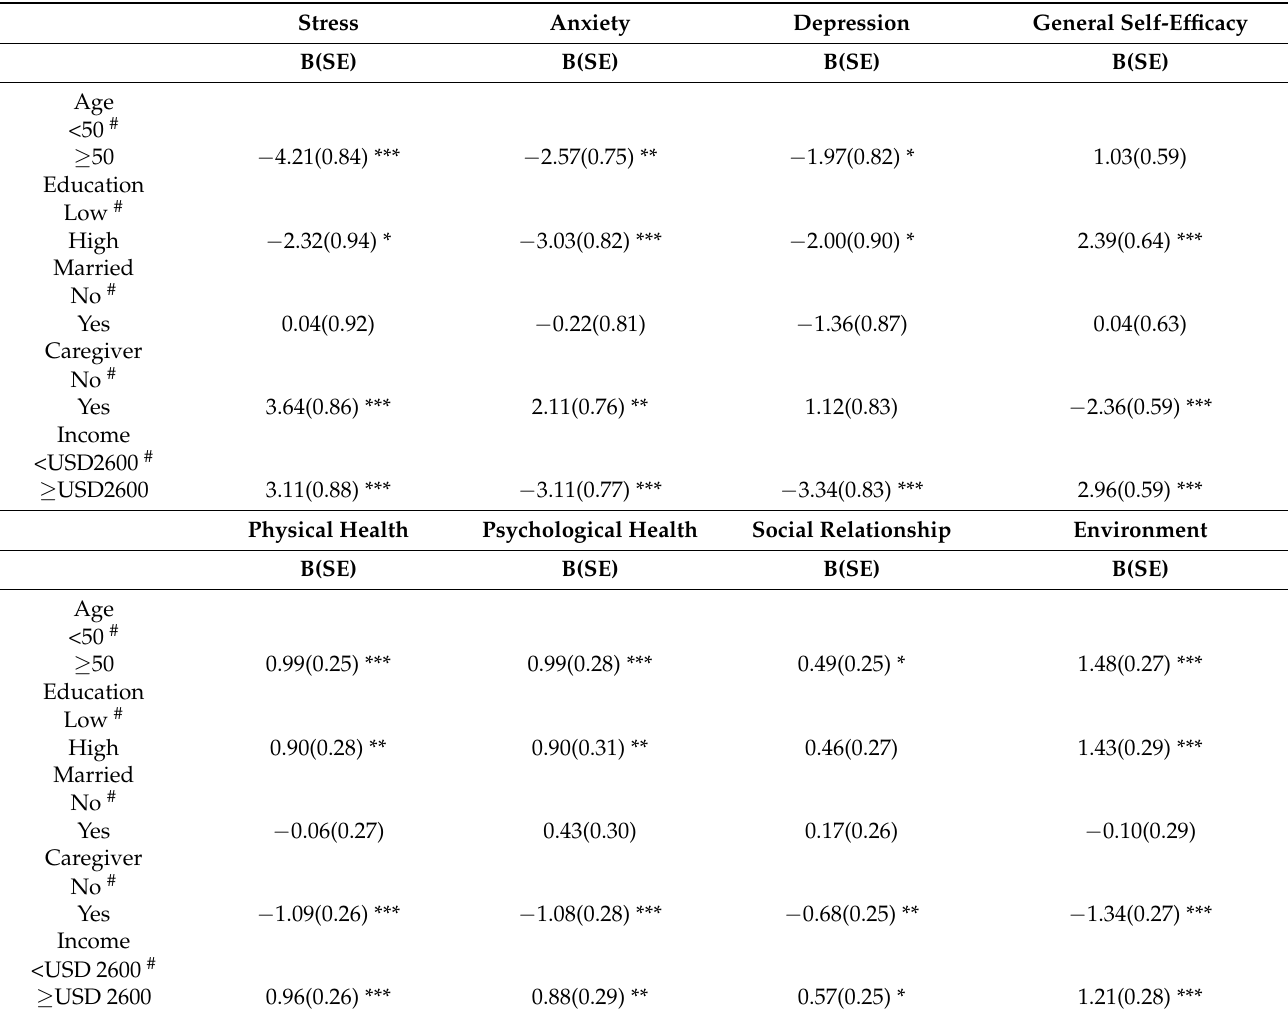
Table 4. Bivariate regression models of emotional states, general self-efficacy and the four domains of quality of life.